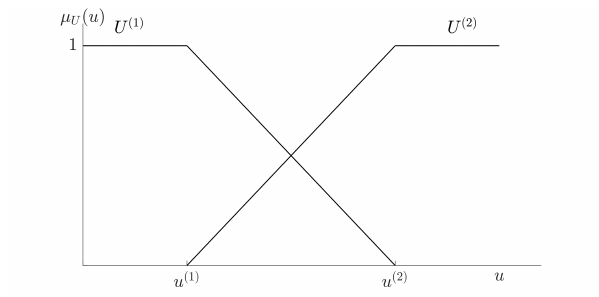
Figure 9. Triangular membership functions for the reference input u